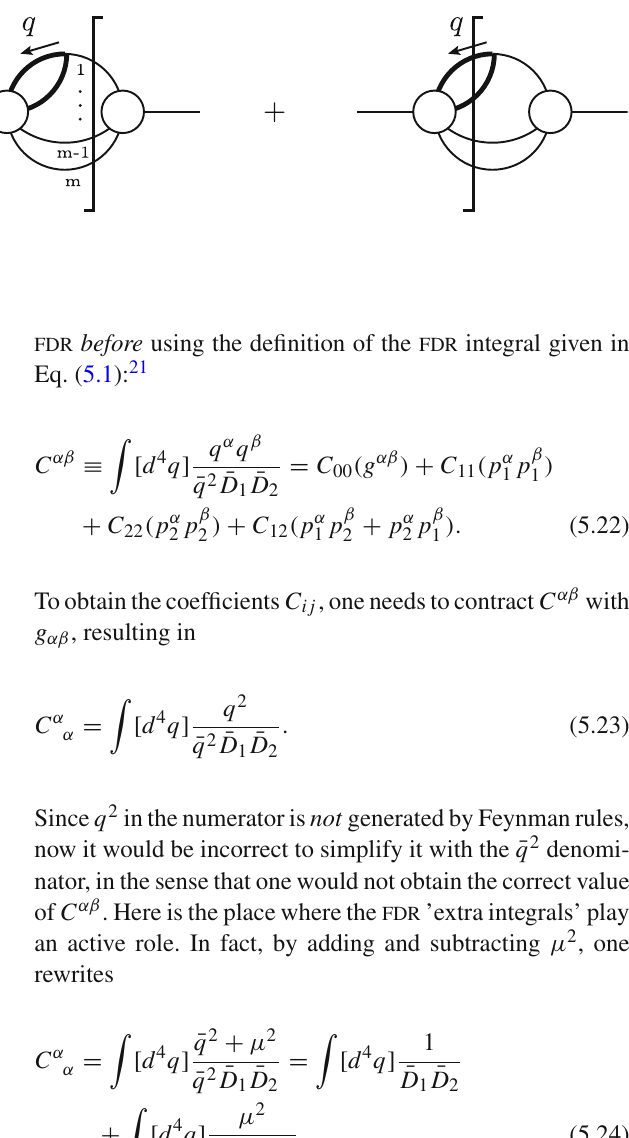
Fig. 11 IR divergences drop out when summing the m -particle virtual piece σ (v) and its real ( m + 1 ) -particle counterpart σ ( r ) . Adding the contributions gives the fully inclusive NLO cross section